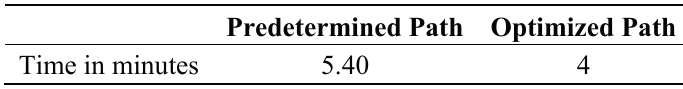
Table 3. Simulation results for one round